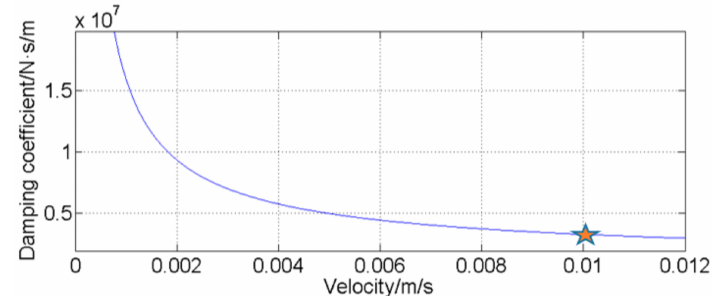
Figure 8. Damping rod’s coe ffi cient–velocity